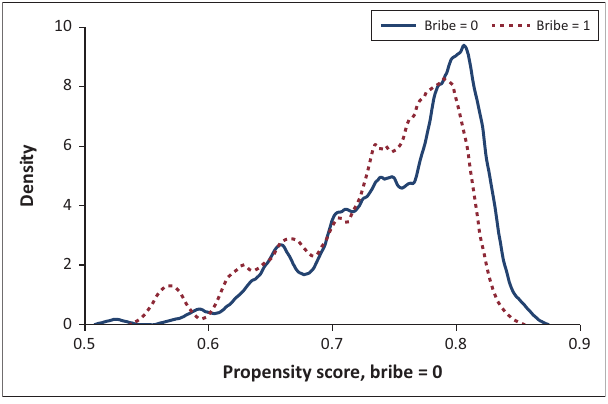
FIGURE 2: Common support between the he bribing and non-bribing